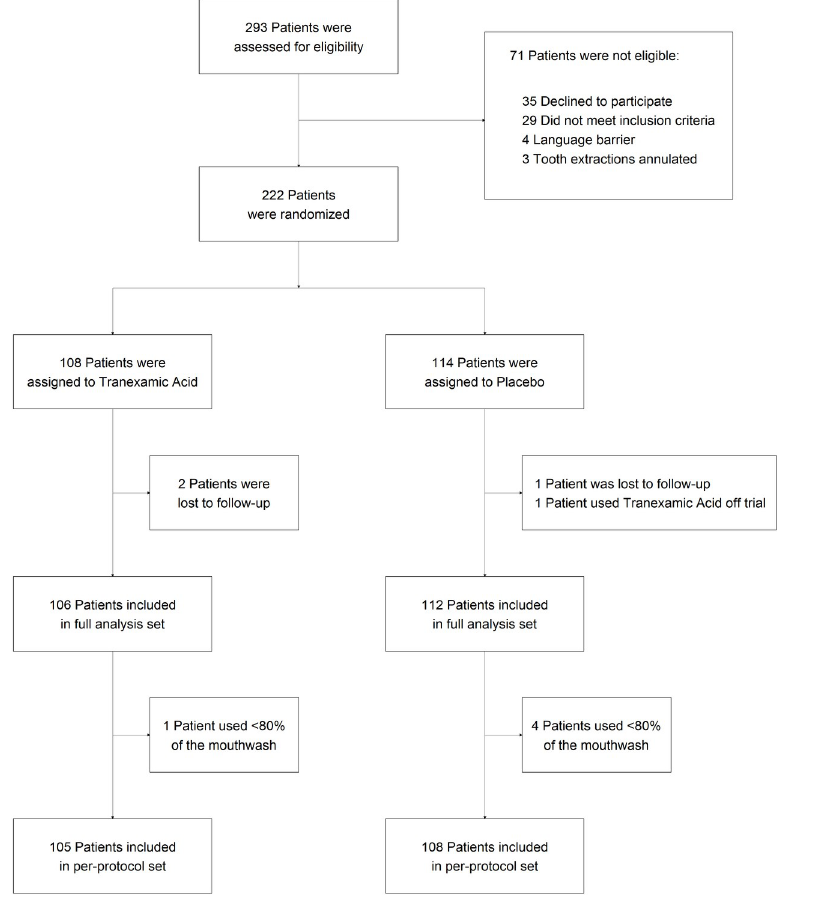
Fig 1. Screening, randomization, follow-up, and analysis of